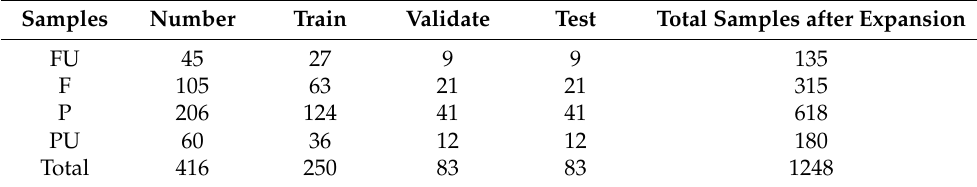
Table 3. Samples division table.